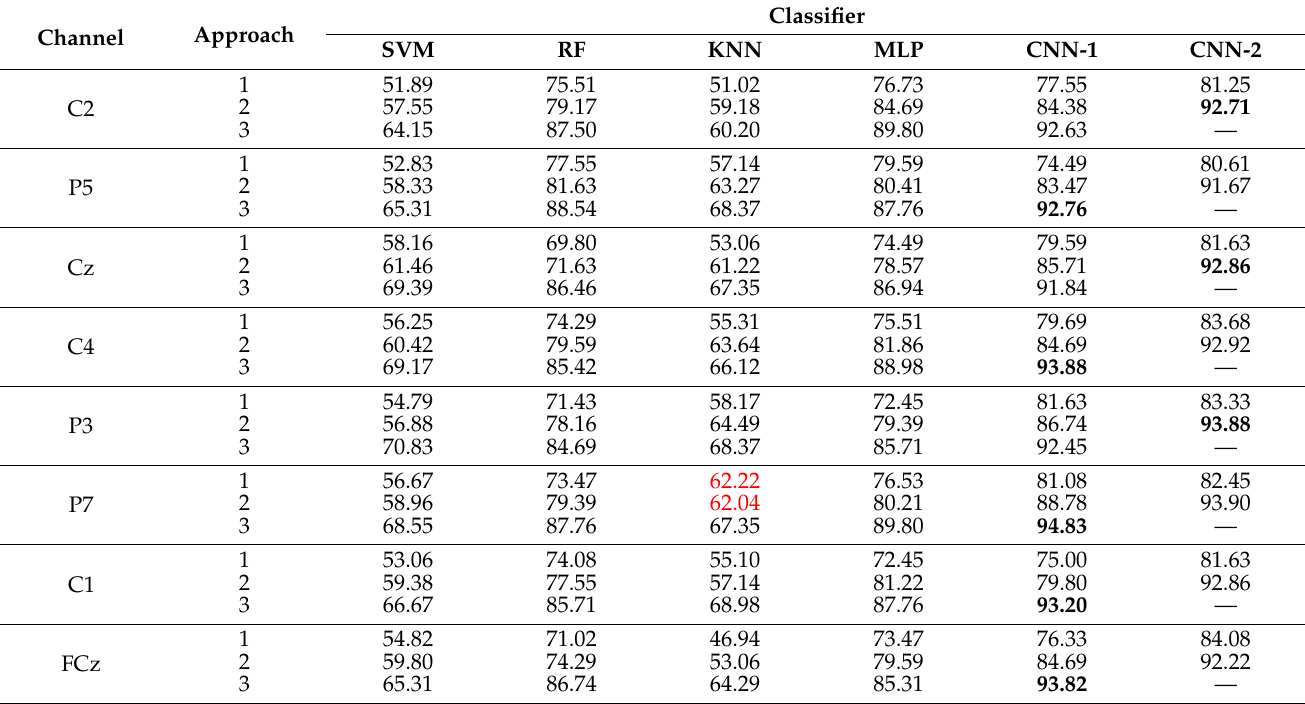
Table A5. Classification accuracies of the ERPs of Subject b 5 . Inconsistent results are highlighted in red. The best result for each channel is highlighted in bold font.